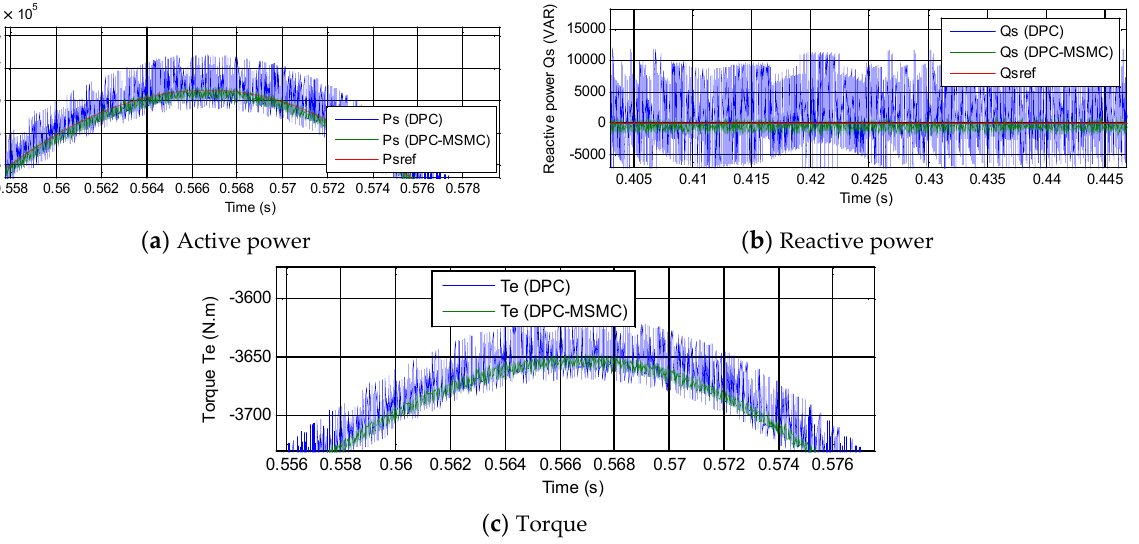
Figure 10. Zoom in the reactive power, torque, active power and current (variable-speed wind test). Table 5. Comparison of ripple values between the designed and the traditional DPC technique (var- iable speed wind test).